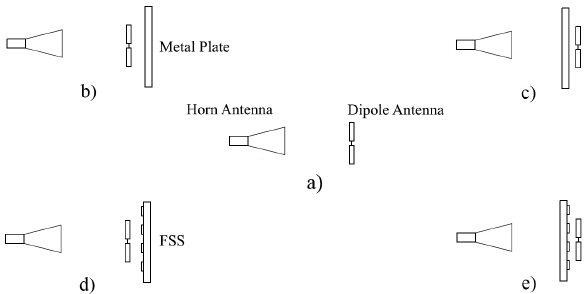
Figure 9: Scenarios for the antenna measurement. a) Free space; b) Antenna and metal plate reflecting; c) Antenna and metal plate blocking; d) Antenna and FSS reflecting; e) Antenna and FSS Blocking.